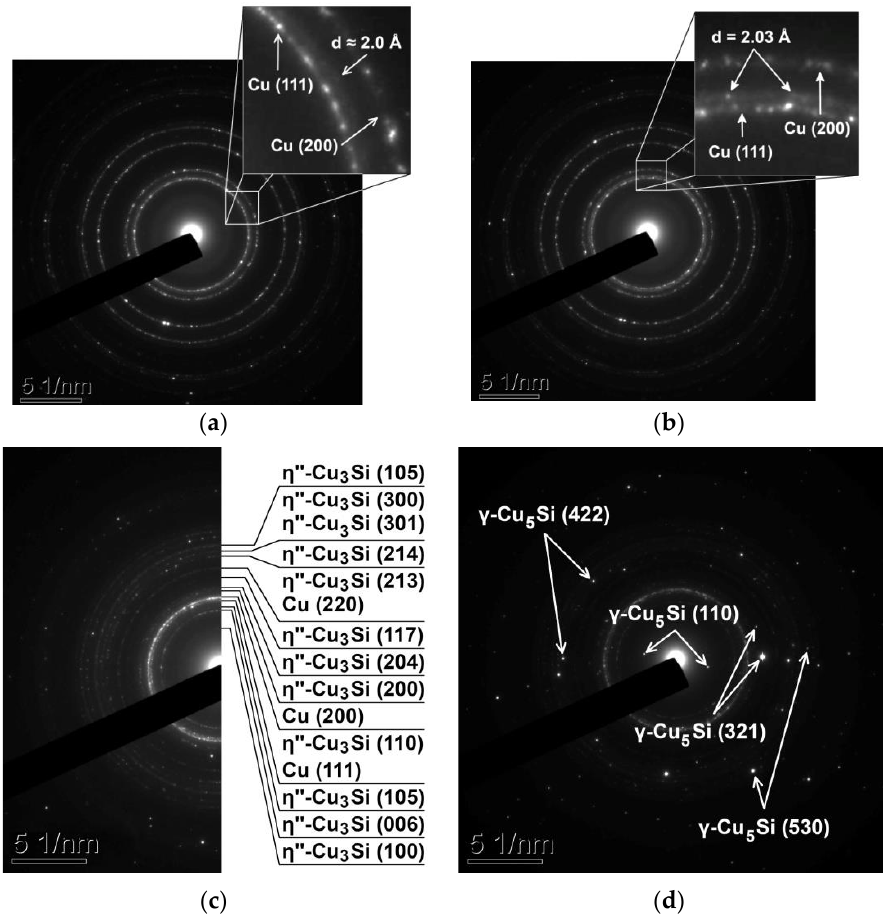
Figure 3. SAED patterns obtained from the Cu/a-Si bilayer thin film at 127 °C ( a ), 166 °C ( b ), 182 °C ( c ), and 255 °C ( d ) during heating at a rate of 5 °C/min.